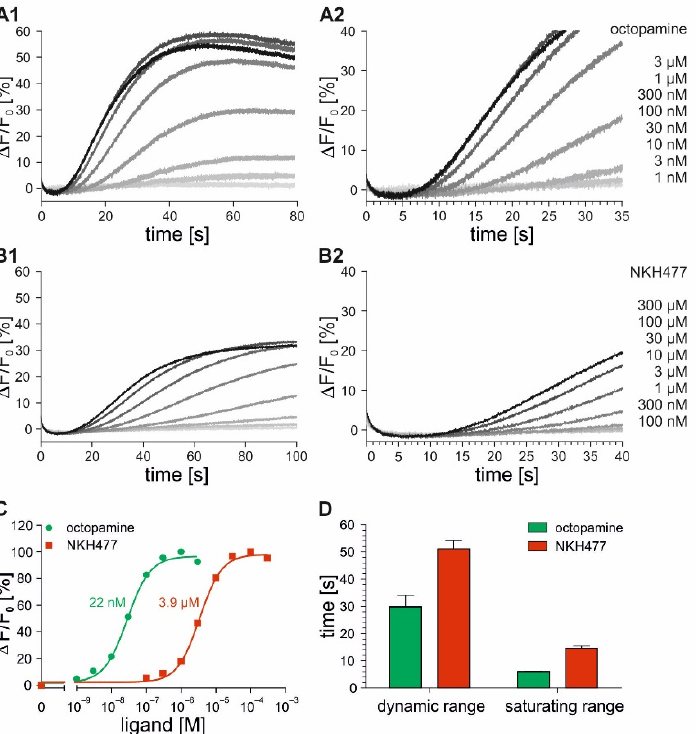
Figure 4. Stopped-flow experiments with flpTM-DmOct β 1 cells loaded with Fluo-4. Fluo-4-loaded flpTM-DmOct β 1 cells were stimulated in stopped-flow experiments with increasing octopamine ( A ) and NKH477 ( B ) concentrations. Fluorescence intensities were monitored over 80 s and 100 s, respectively. Fluorescent changes ( ∆ F/F 0 ) for each octopamine and NKH477 concentration were calculated and plotted over time ( A1 , B1 ). To resolve signal response times, the initial 35 s and 40 s of each measurement are displayed ( A2 , B2 ). Shown are representative measurements from three independent datasets. Each data point was obtained from triplicate measurements; ( C ) Concentration–response curves were generated by plotting maximal changes in fluorescence against octopamine (green) and NKH477 (red) concentrations. Maximal changes in fluorescence at the highest ligand concentrations were normalized to 100% and EC 50 values were obtained from nonlinear fitting of the data using GraphPad Prism v5.04. Shown is a representative concentration–response curve from three independent datasets. Mean EC 50 values are indicated; ( D ) Bar graph showing the time until signal was detected at concentrations in the range of EC 50 values (dynamic range) and at saturating concentrations (saturating range) for octopamine (green) and for NKH477 (red). Each data point was obtained from triplicate measurements. Shown are mean values ± SEM from three independent datasets.